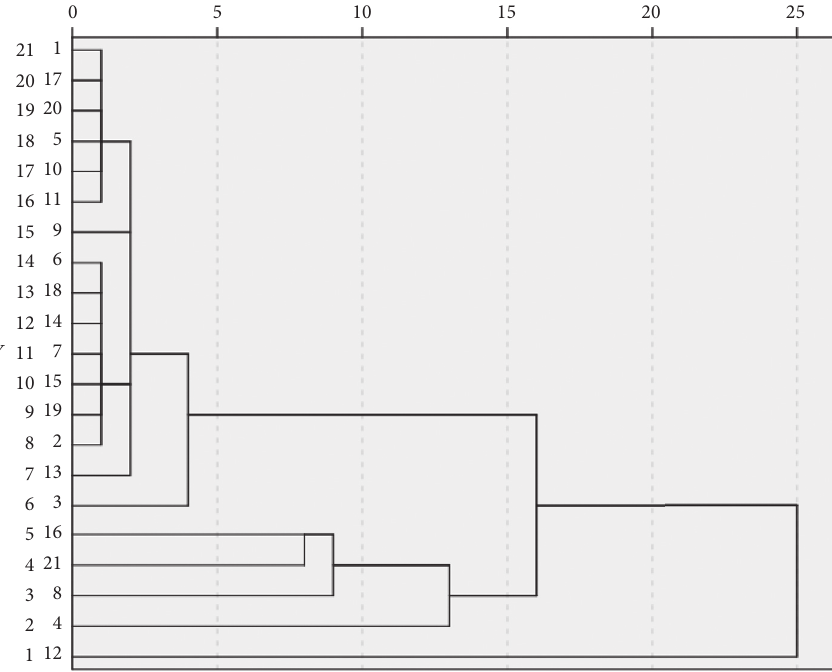
Figure 4: Cluster analysis.